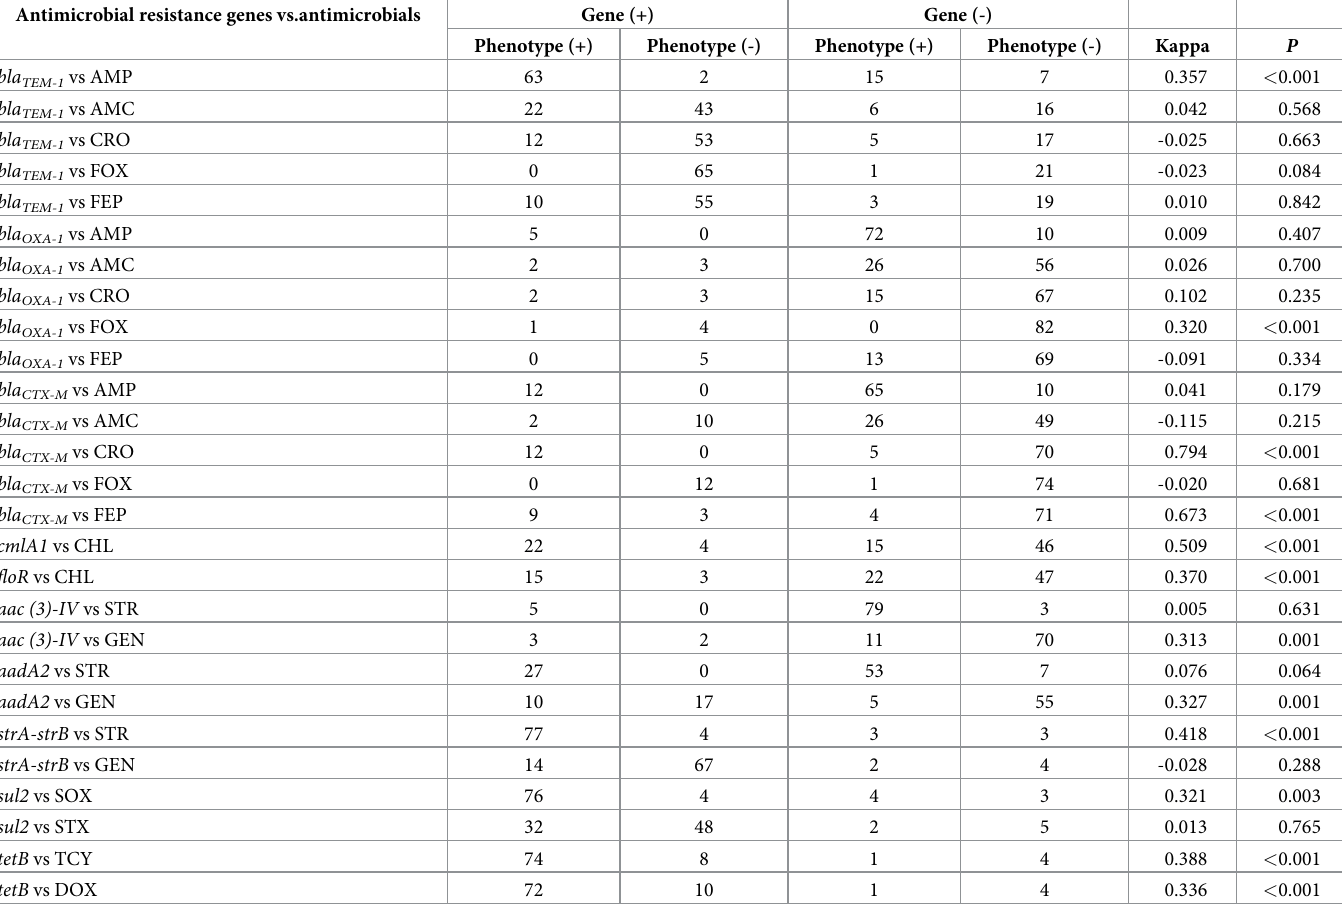
Table 3. The correlation between the phenotypic and genotypic of Salmonella 4,[5],12:i:- isolates. Antimicrobial resistance genes